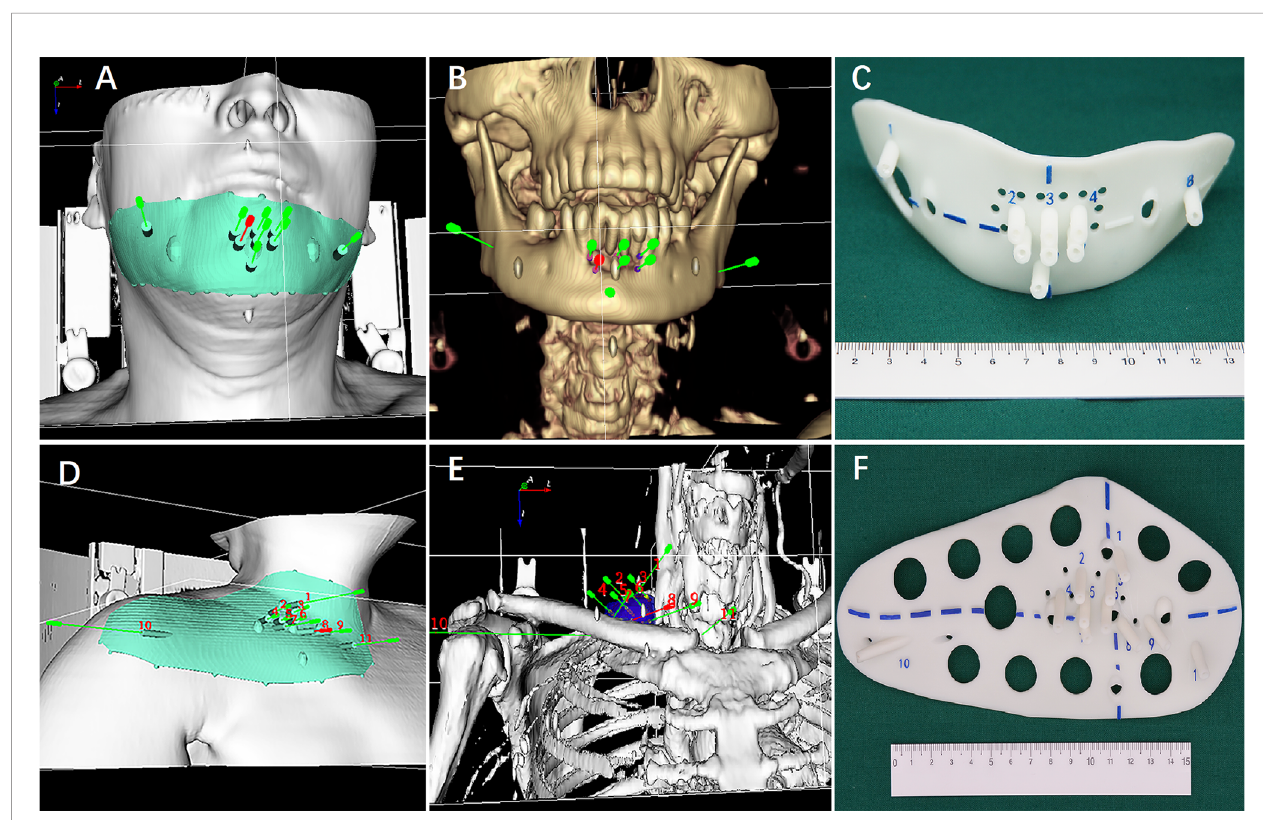
FIGURE 2 | (A, B and D, E) Digital modeling of the individualized 3D-printing template (3D-PT) for head and neck; (C, F) The 3D-PT (3 mm thickness) with entrance aisle for an 18-gauge needle (the entrance aisle and the needle was perfectly matched; therefore, the needle ’ s angle was